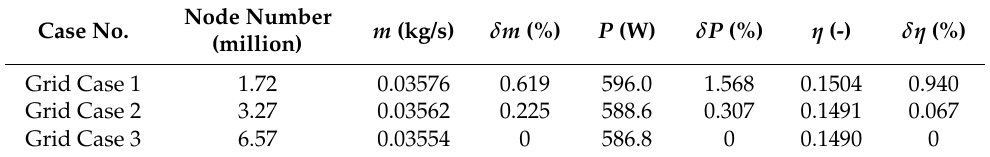
Table 4. Mesh independence [23].